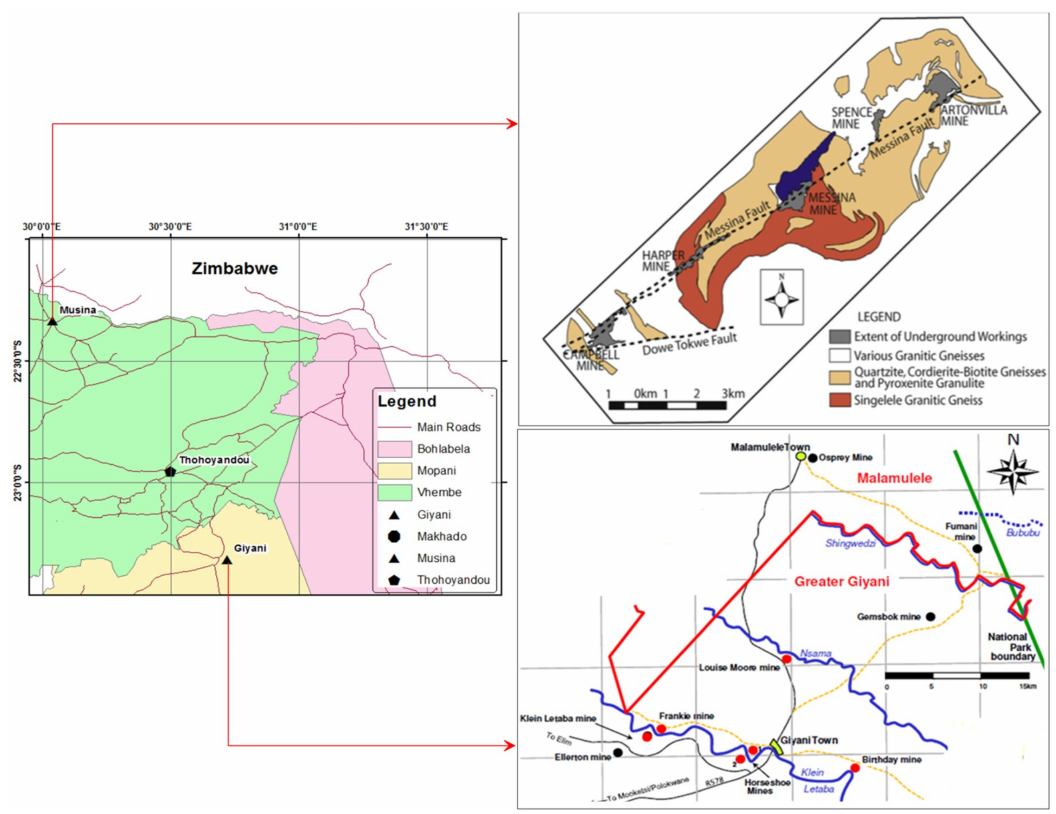
Figure 1. The location of abandoned mine sites in the Giyani and Musina areas